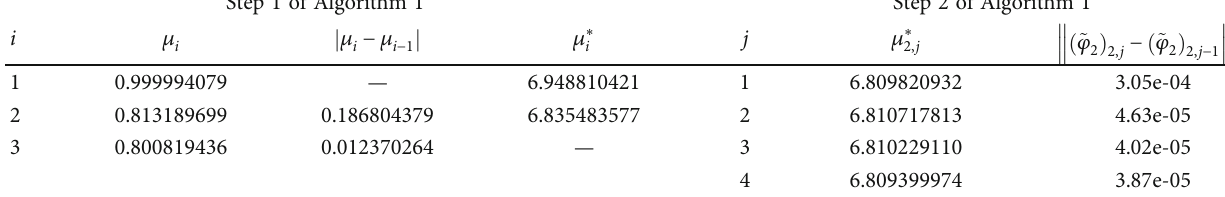
ð x , y Þ = ð 1 : 003 x 2 + 0 : 997 y 2 Þ /2 , ε = 1/ 2